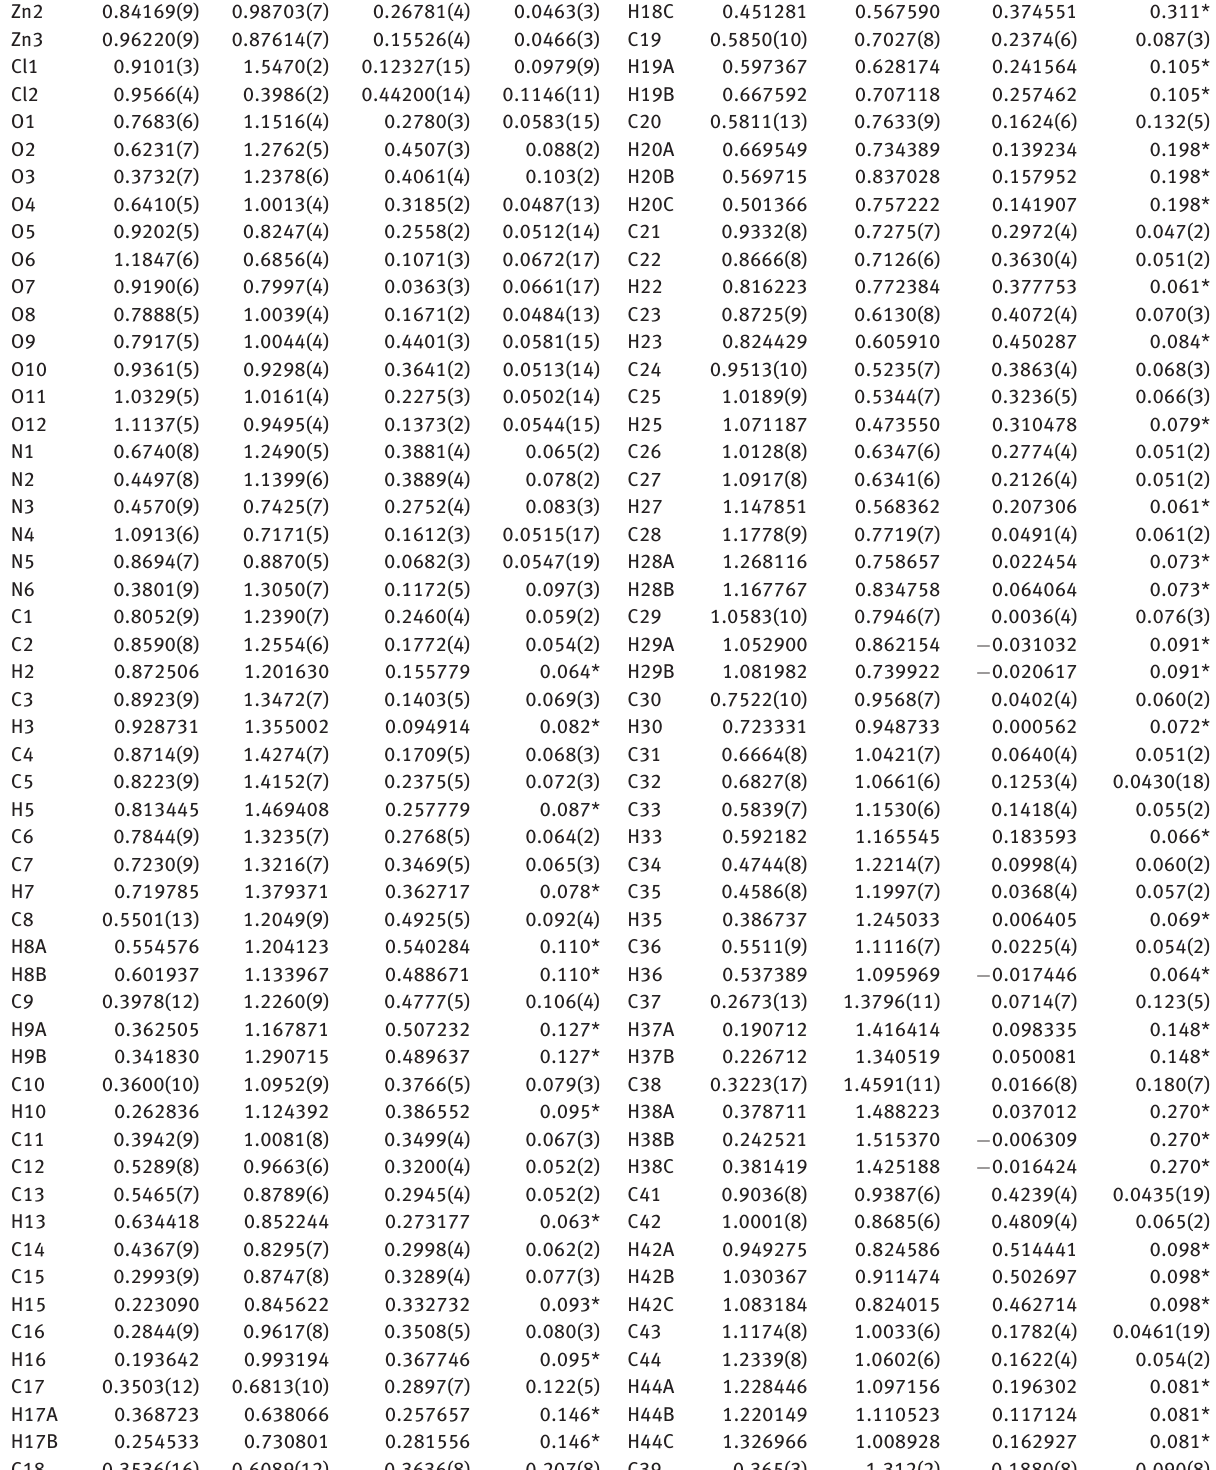
Table 2: Fractional atomic coordinates and isotropic or equivalent isotropic displacement parameters (Å 2